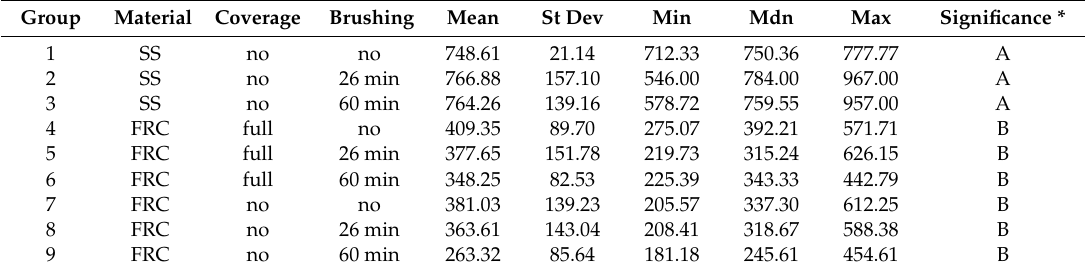
Table 2. Descriptive statistics (MPa) of the maximum bending stress of the di ff erent groups.